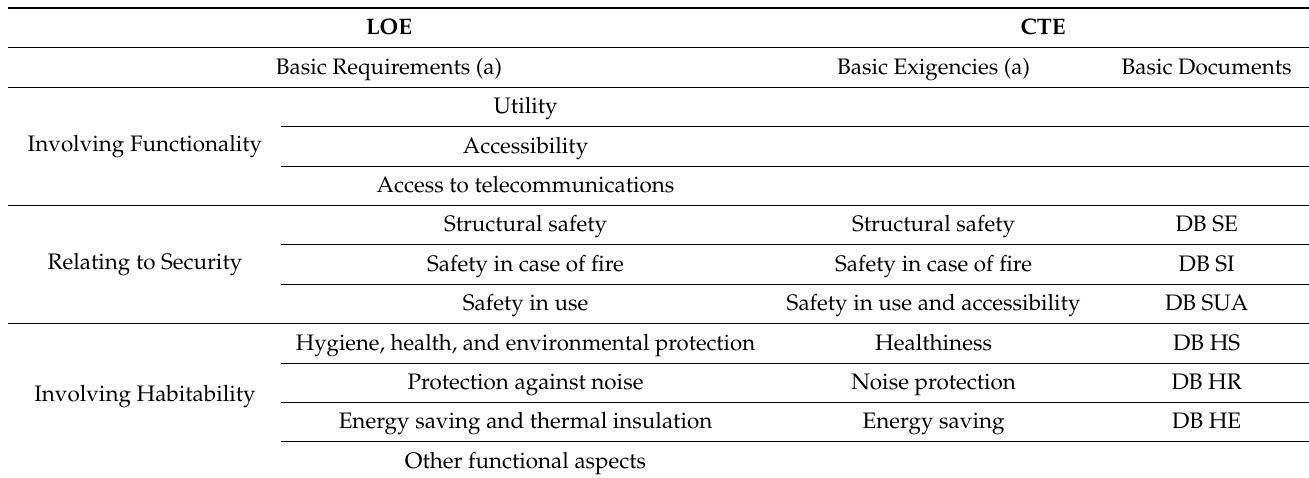
Table 7. Basic Requirements provided by the LOE and Basic Exigencies and associated Basic Document of the CTE. (As interpreted by the authors).